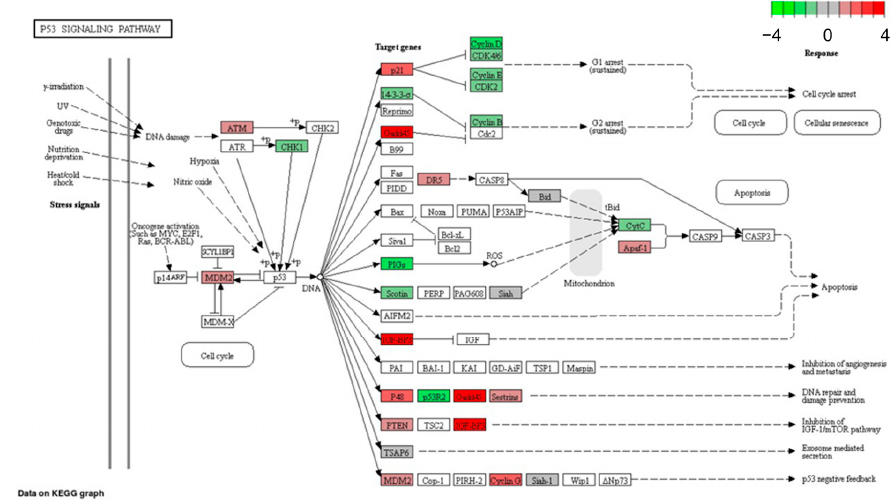
Figure 2. Hypoxia induced p53 KEGG pathway in MCF ‐ 7 cells (wtp53) (Benjamini ‐ Hochberg adjusted p < 0.05). Apaf ‐ 1, apoptotic peptidase activating factor 1; ATM, ataxia telangiectasia mutated; CDK2/4/6, cyclin ‐ dependent kinase 2/4/6; CHK1, cell cycle checkpoint kinase; CytC, cytochrome C; DR5, death receptor 5; GADD45, growth arrest and DNA damage ‐ inducible protein 45; IGFBP3, insulin ‐ like growth factor ‐ binding protein 3; MDM2, mouse double minute 2 homolog; PIGs, p53 ‐ induced gene; PTEN, phosphatase and tensin homolog; p21 (=CDKN1A), cyclin ‐ dependent kinase inhibitor 1A; p48 (=PTF1A), pancreas associated transcription factor 1a; p53R2 (=RRM2B), ribonucleotide reductase regulatory TP53 inducible subunit M2B); SESN2, sestrin ‐ 2; Siah ‐ 1, seven in absentia homolog 1; TSAP6 (=STEAP3), tumor suppressor ‐ activated pathway protein 6; 14 ‐ 3 ‐ 3 σ , Stratifin.